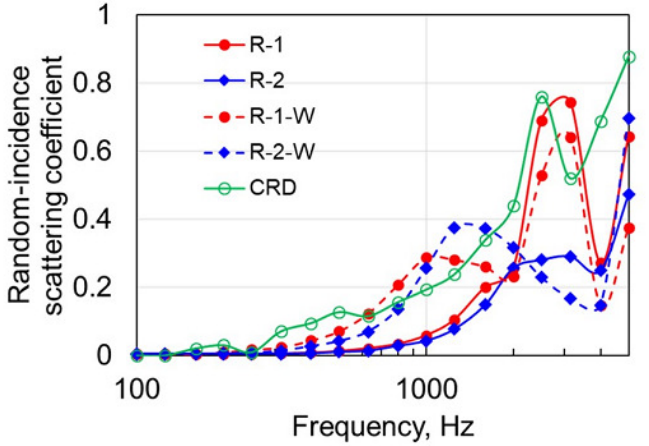
Figure 4. Random-incidence scattering coefficients of various 1D periodic rib diffusers (R-1, R-2, R-1-W and R-2-W) and the